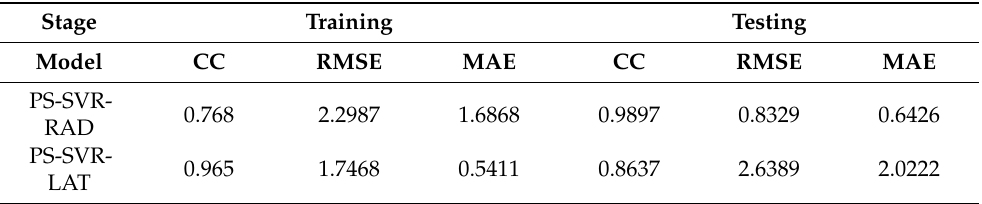
Figure 3. Convergence and PS-SVR-RAD model sensitivity to hyper-parameters. ( a ) PS-SVR-RAD model sensitivity to root mean square error(RMSE) at various population size ( b ) PS-SVR-RAD model sensitivity to penalty factor at various population size ( c ) PS-SVR-RAD model sensitivity to epsilon at various population size ( d ) PS-SVR-RAD model sensitivity to kernel parameter at various population size. Table 2. Comparison of the model performance evaluation parameters. (CC = correlation coefficient, RMSE = root mean square error, MAE = mean absolute